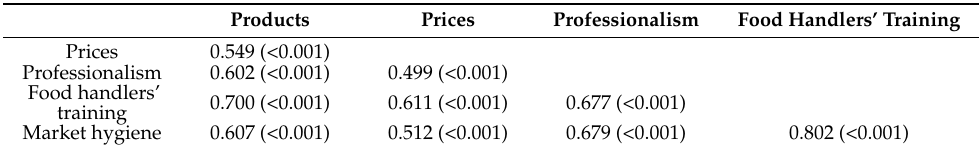
Table 4. Pearson correlations ( p